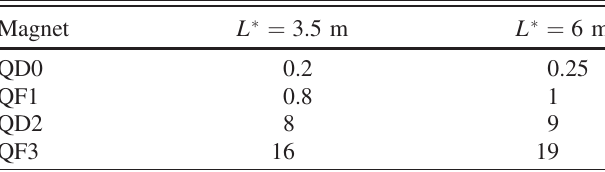
TABLE VI. Vertical offset tolerances (in nanometers) for the last quadrupole magnets in the CLIC FFS for a relative peak luminosity loss of 2%.